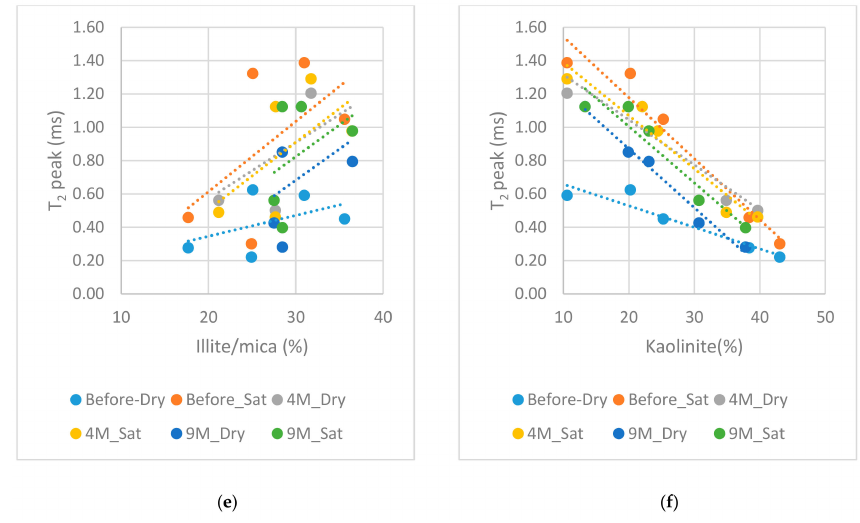
Figure 17. Influence of Illite / mica and kaolinite on various parameters. ( a ) BET Surface Area vs. Illite / mica ( b ) BET Surface Area vs. kaolinite ( c ) MICP porosity vs. Illite / mica ( d ) MICP porosity vs.